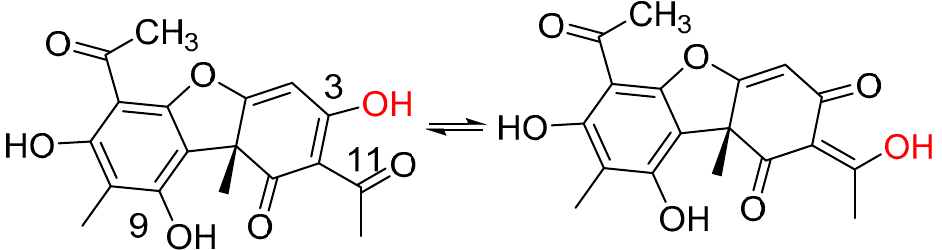
Figure 4. Enolic forms of usnic acid. Enolic proton marked with red.